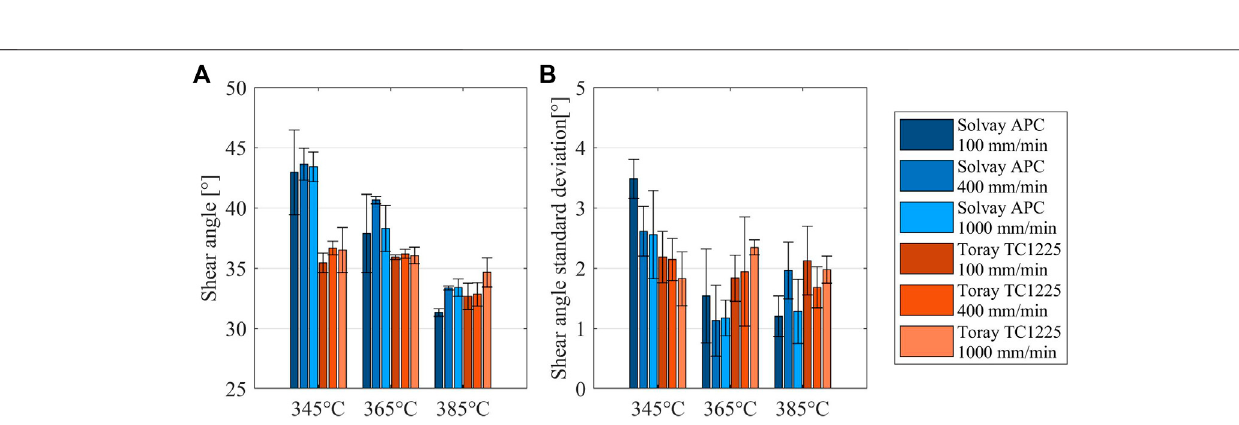
Frontiers in Materials |